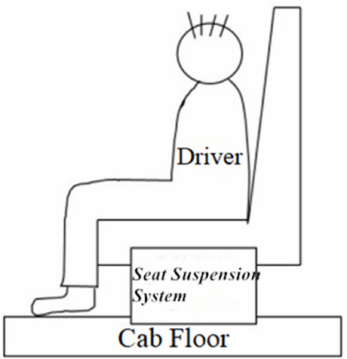
Figure 1. Simplified model of the vehicle seat.